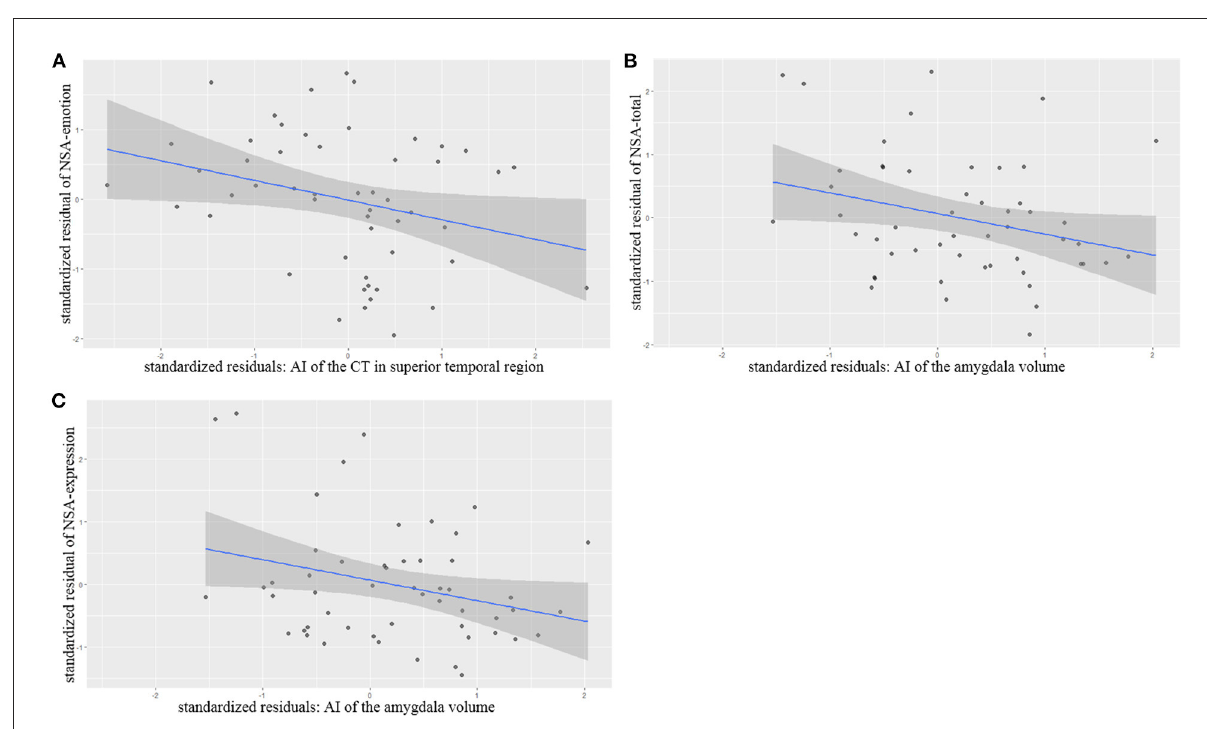
FIGURE2 (A–C) Partial correlation between brain structural changes and NSA